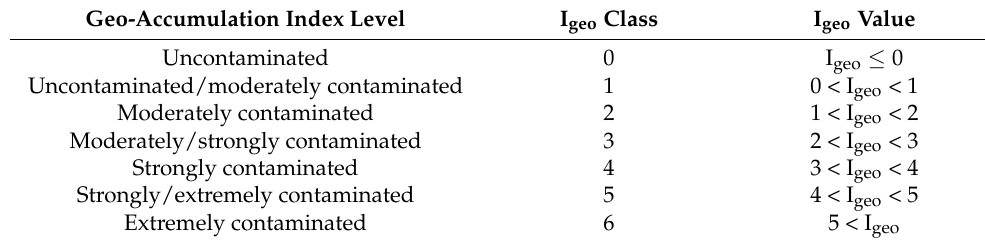
Moderately/strongly contaminated